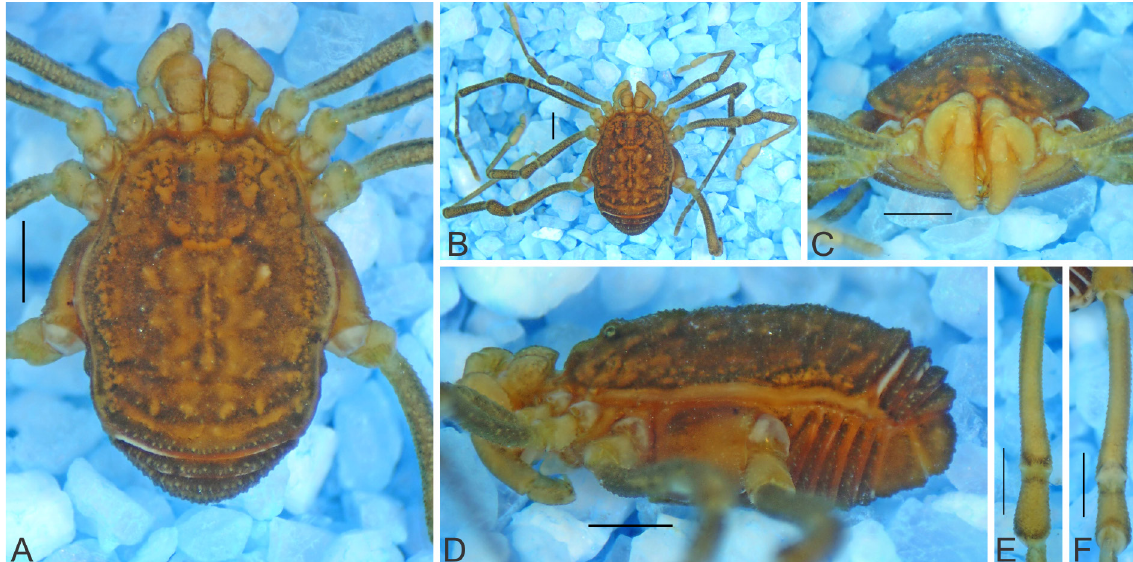
Fig. 1. Libitia bipunctata Sørensen, 1932, ♂ (ICN-AO 1040), habitus. A . Dorsal view. B . Dorsal view, panoramic. C . Frontal view. D . Lateral right view. E–F . Right femur IV, dorsal and ventral view, respectively. Scale bars = 1 mm.